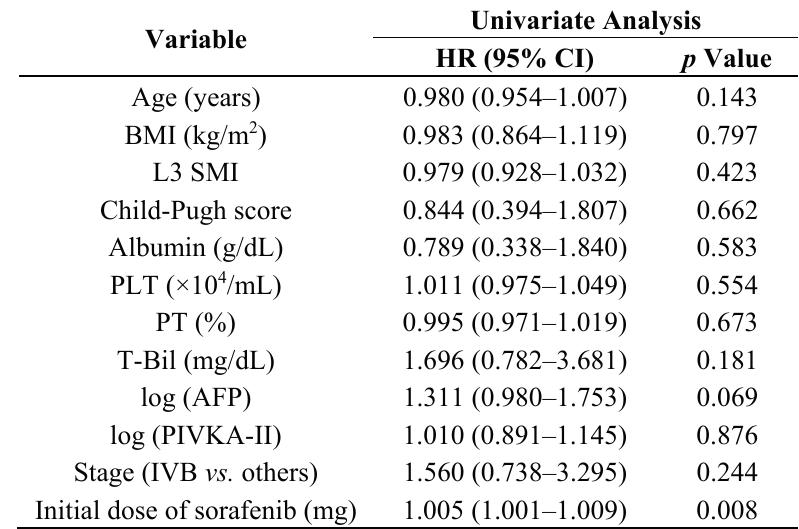
Table 3. Univariate and multivariate analyses of possible risk factors for dose reduction of sorafenib due to its toxicity by Cox proportional hazards